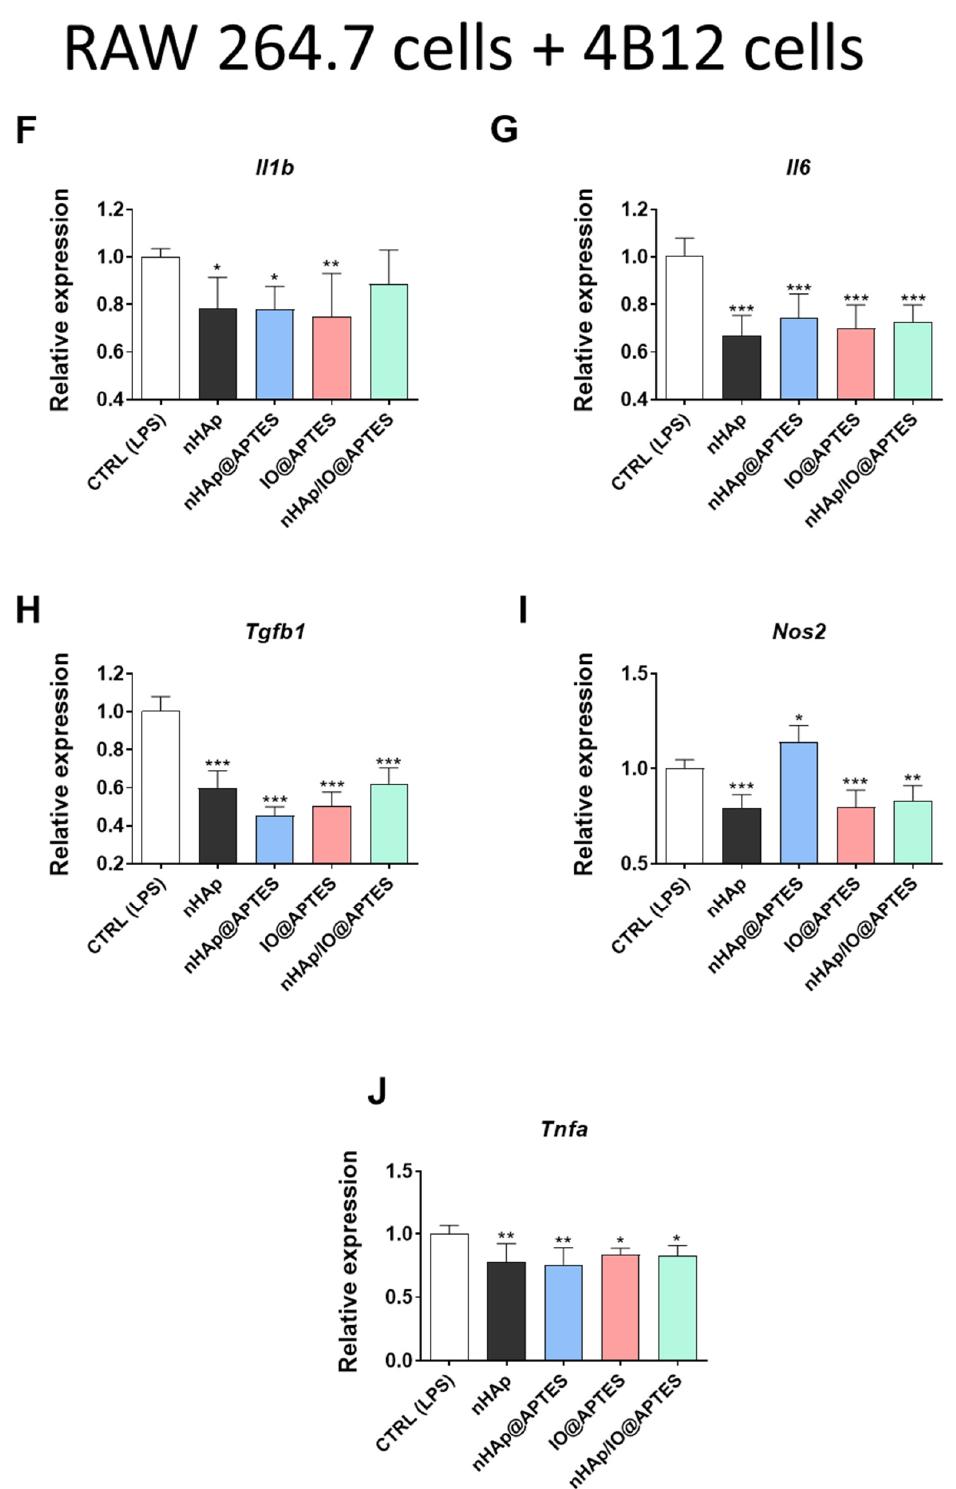
Figure 8. Assessment of inflammation. The impact of the biomaterials on the expression of genes associated with inflammation status Il1b ( A ), Il6 ( B ), Tgfb1 ( C ), Nos2 ( D ) and Tnfa ( E ) after 20 h of incubation of MC3T3-E1 cell line. Expression of genes associated with inflammation status Il1b ( F ), Il6 ( G ), Tgfb1 ( H ), Nos2 ( I ) and Tnfa ( J ) after 20 h of incubation of 4B12 cell line. The graphs represent mean values ± standard deviation. Significant differences are indicated as follows: (* p < 0.05, ** p < 0.01 and *** p <